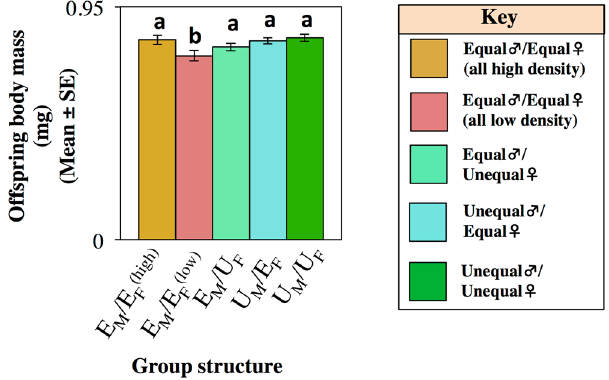
Figure 4. Offspring body mass. Average offspring body mass (in mg) (Mean ± SE). Post-hoc SNK test ( α =